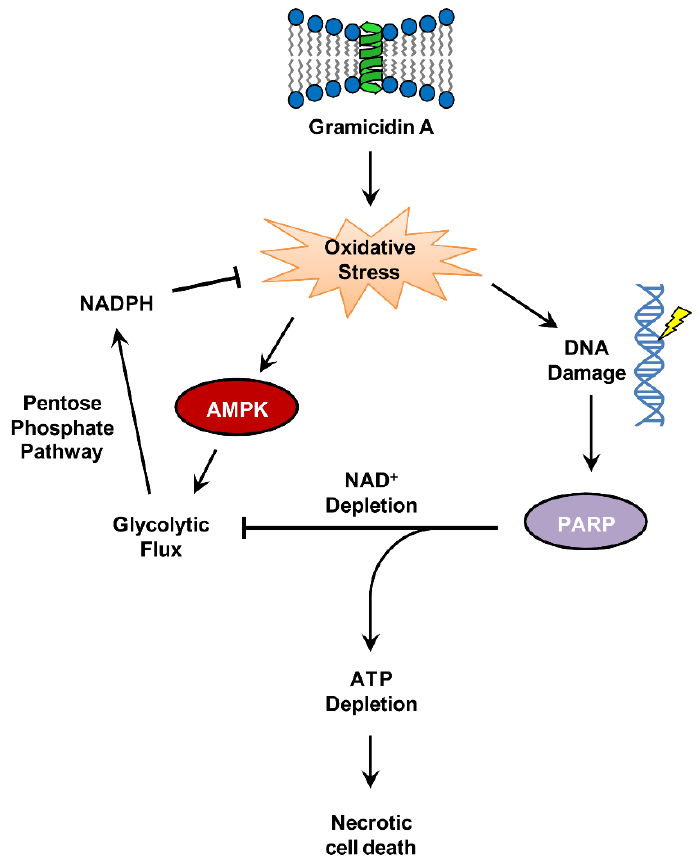
Figure 2: Proposed model of GA cytotoxicity. GA may induce oxidative stress, which can activate AMPK to increase glycolytic flux. This in turn can increase NADPH production via the pentose phosphate pathway, and NADPH regenerates glutathione to detoxify ROS. Oxidative stress also damages DNA leading to the activation of PARP. Overactive PARP depletes NAD+, which inhibits glycolysis leading to ATP depletion and subsequent necrotic cell